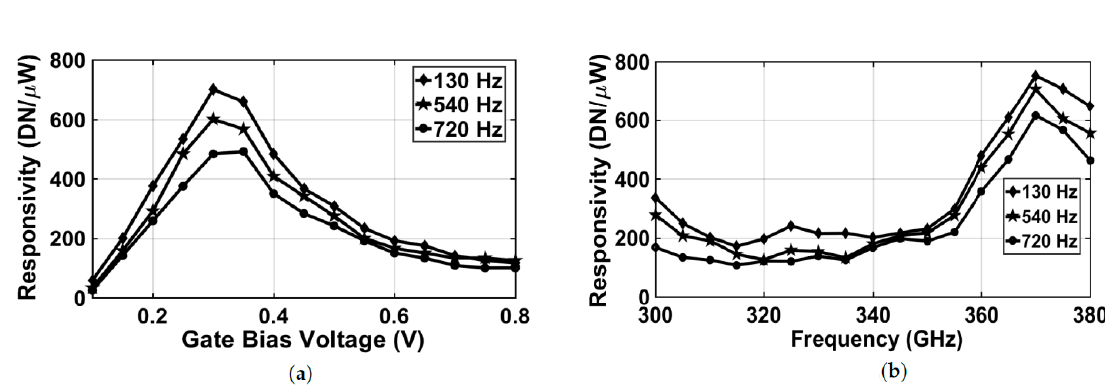
Figure 18. Readout responsivity as a function of FET gate bias voltage ( a ) and signal frequency ( b ).